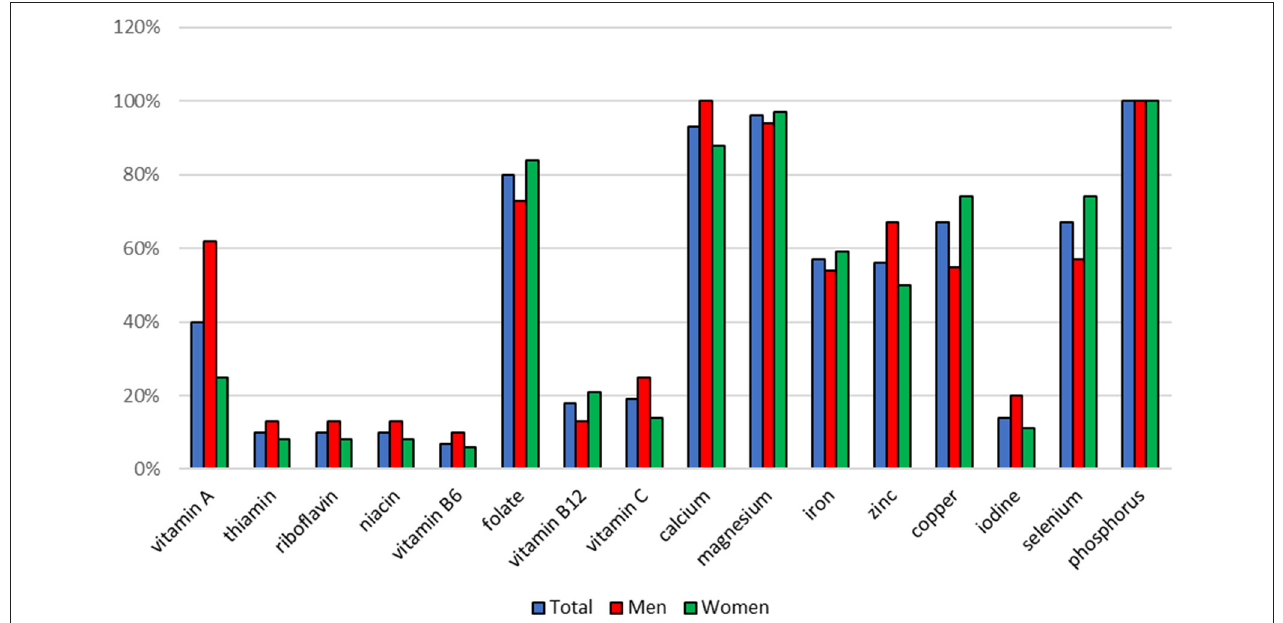
FIGURE 4 | Percentage of people whose intake of vitamins and minerals from food supplements was lower than the EAR value.